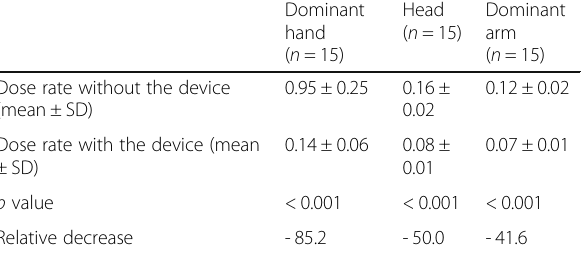
Table 2 Fluoroscopy time, success rate, and complications with and without the passive robotic